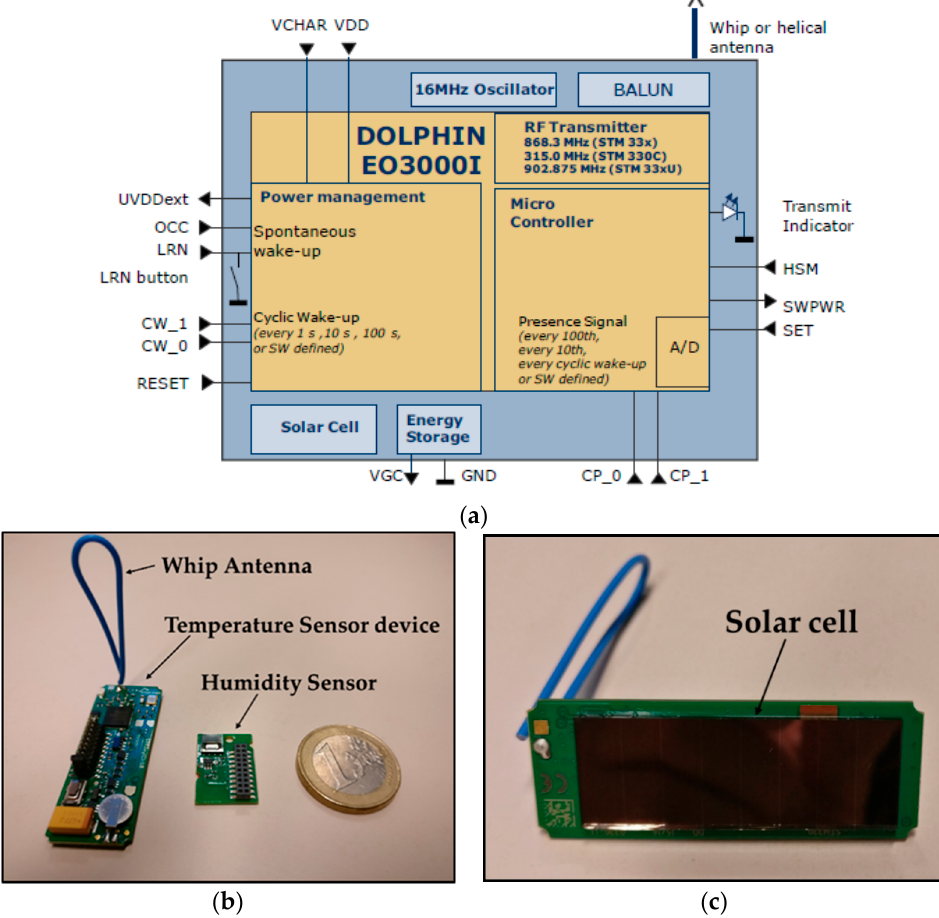
Figure 2. ( a ) Simplified device block diagram (extracted from STM 330 user manual). ( b ) EnOcean’s STM 330 module and the includable humidity sensor. ( c ) Detail of the STM 330 module’s solar cell.